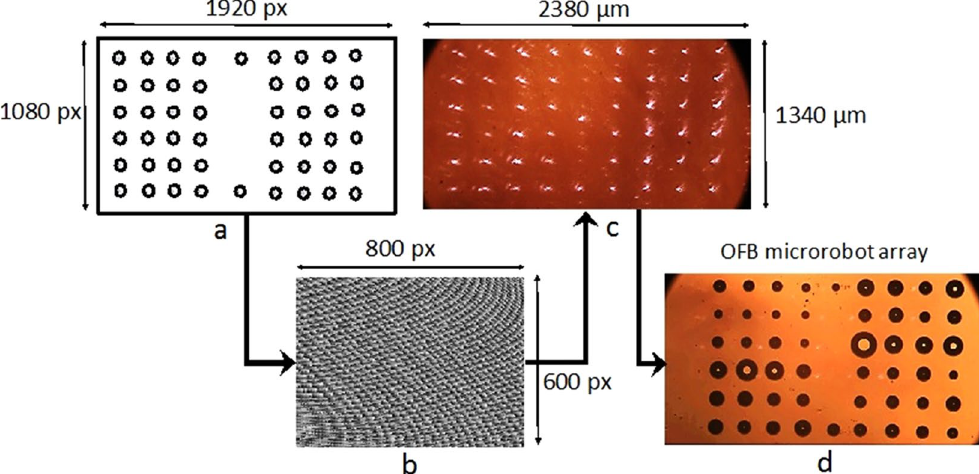
Figure 2. User-defined OFB microrobot control pattern generation. ( a ) A pattern of 50 focused laser spots for the control of 50 OFB microrobots created by the user. ( b ) The corresponding hologram used to create the optical pattern from a single input laser is generated and displayed on the spatial light modulator. ( c ) The optical pattern as viewed through the microscope. ( d ) Fifty OFB microrobots controlled using the optical